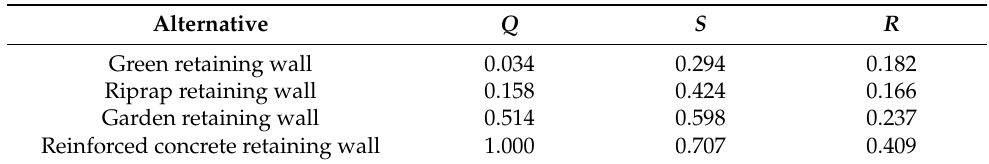
Table 6. Ranking of alternatives according to the VIKOR method. Project 2. Source: the authors’ own